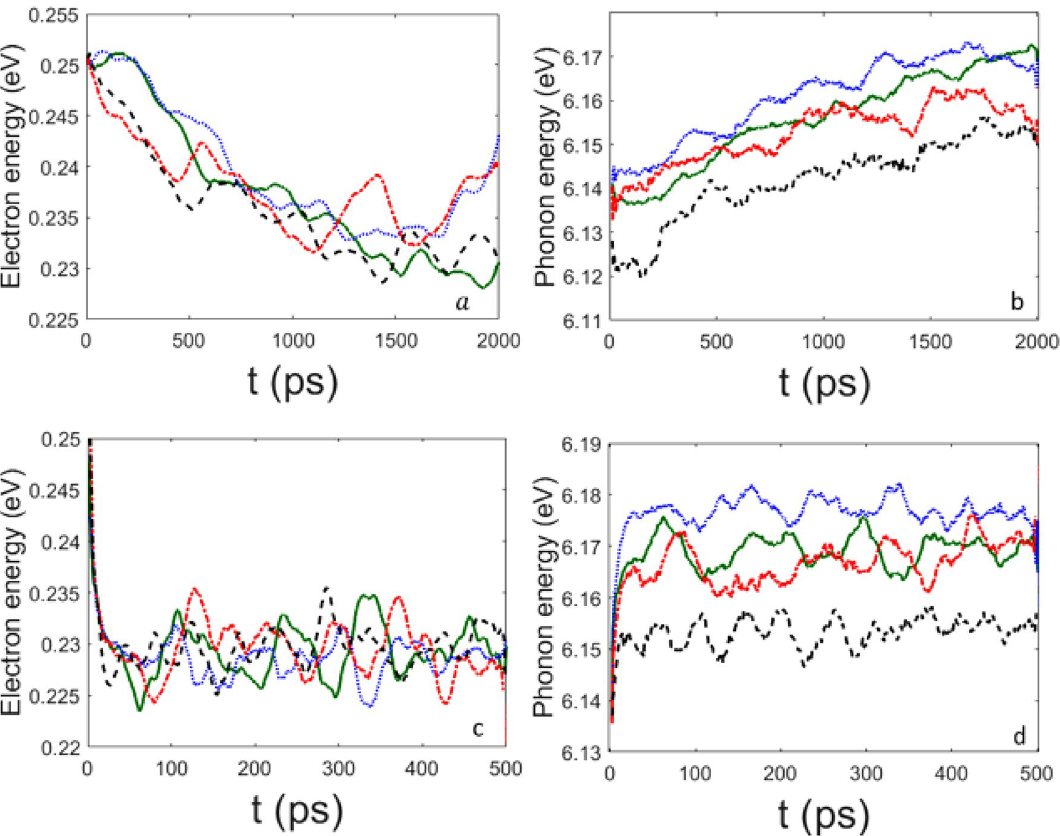
Figure 5. Time behavior of electron energy (left panels) and phonon energy (right panels). Upper panels refer 0.5 ( χ 61 pN) and for: µ 0 (green solid line), µ to χ ′ ′ = = = 0.5 (black dashed line). Lower panels refer to χ line), and µ ′ = 0.1 (blue dotted line), µ 0.3 (red dot-dashed line), and µ line), µ ′ ′ = = 13 measured in 10 − s; electron energy and total phonon energy are given in eV. The other parameters are the same of Fig.